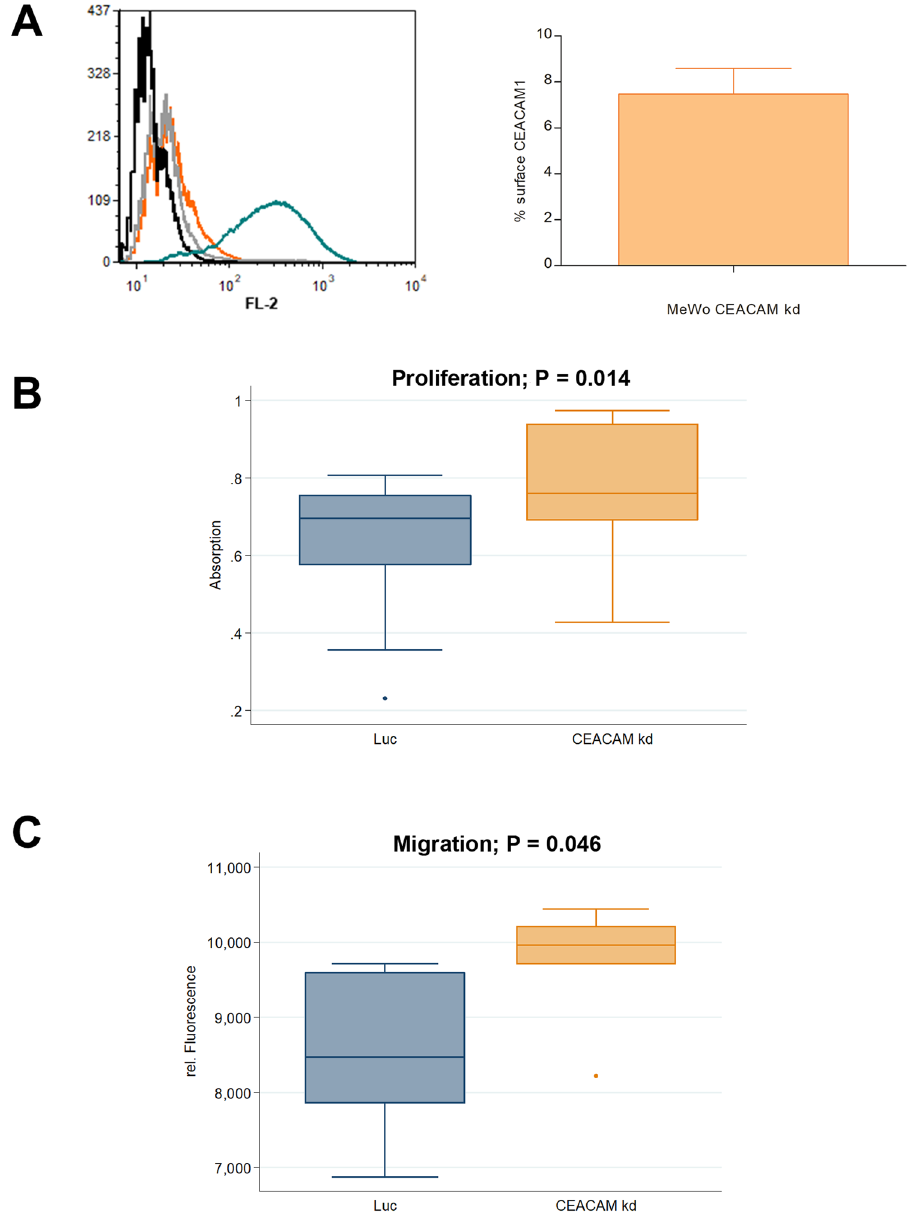
Figure 1. CEACAM1 knockdown in human melanoma cells and in vitro characterization. ( A ) Left Panel: Flow Cytometry, Histogram. Staining of MeWo CEACAM1 kd (orange curve, respective isotype control in grey) and MeWo Luc (teal, respective isotype control in black) for CEACAM1. Right Panel: In contrast to MeWo Luc, surface CEACAM1 is reduced by over 90% in MeWo CEACAM1 kd, given is the percentage of surface CEACAM1 on MeWo CEACAM kd cells as determined by flow cytometry (Staining and measurement repeated twice; respective MeWo Luc signals set as 100%). ( B ) In vitro XTT proliferation assay with MeWo CEACAM1 kd and MeWo Luc. A slight, but significant increase (p = 0.014) in proliferation was observed for MeWo CEACAM1 kd compared with the MeWo Luc controls. The experiment was repeated twice with 6 replicates (wells) each time (n = 18 each group). ( C ) In vitro migration in a transwell assay with MeWo Luc and MeWo CEACAM1 kd: Significant difference in migration between the two cell lines was observed (p = 0.046). The experiment was repeated once with 3 replicates (wells) each time (n = 6 for each